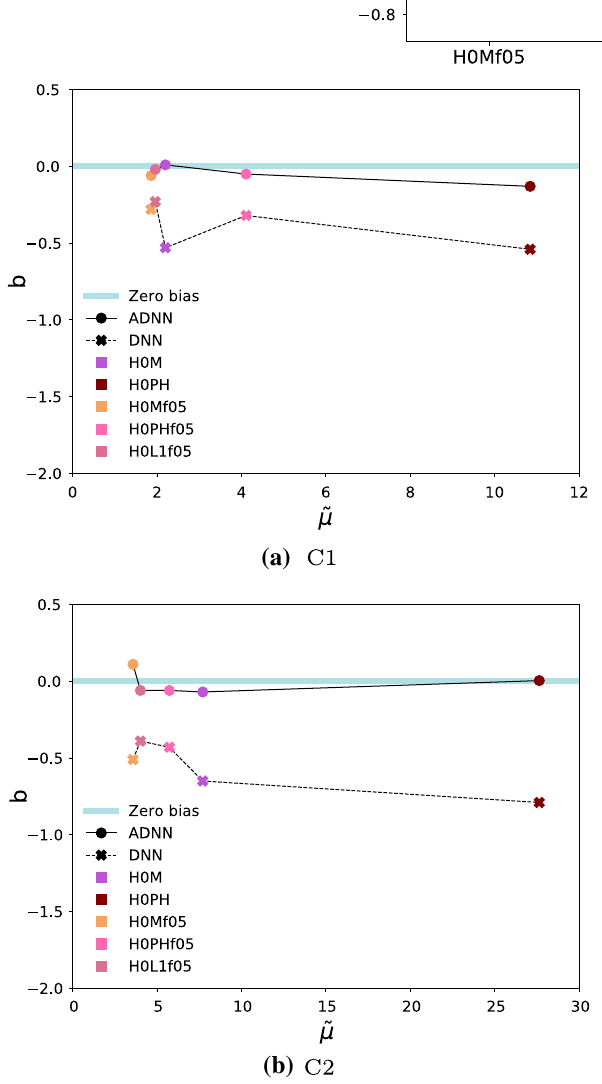
Fig. 12 Bias quantitiesas a function of the expectedvalue of the signal strength